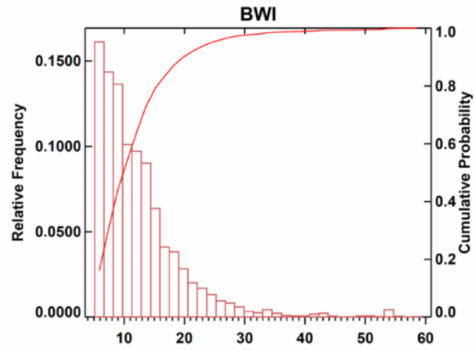
Figure 4. Distribution of hourly average PM 2.5 below clouds at BWI station.